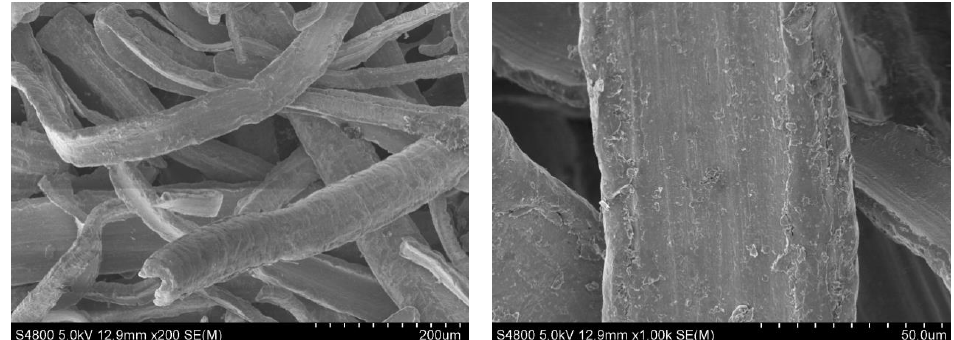
Figure 4. Scanning electron microscope images of steel wool fiber.